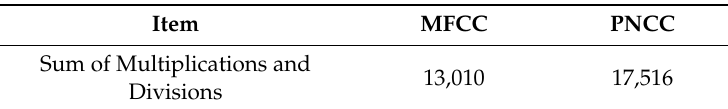
Table 5. Results of computational